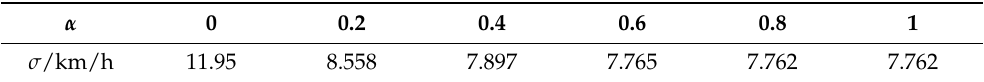
Figure 24. Comparison of the total torque between engine and motor corresponding to the compensable coefficient of different motors under working condition B. ( a ) α = 0; ( b ) α = 0.2; ( c ) α = 0.4; ( d ) α = 0.6; ( e ) α = 0.8; ( f ) α = 1. Table 8. Standard deviation of the torque corresponding to the compensable coefficient of different motors under working condition